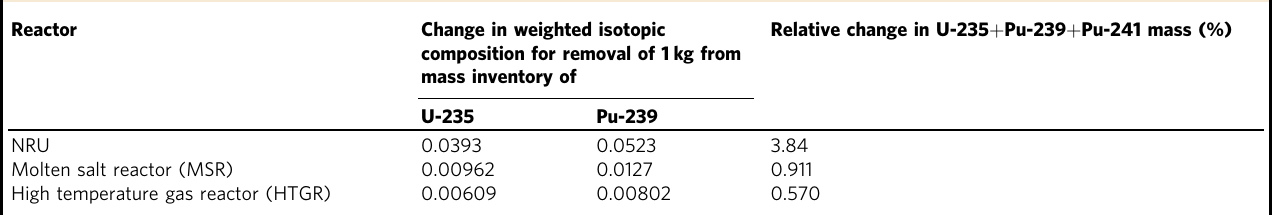
Table 4 Change in weighted isotopic composition from removal of 1 kg of U-235 or Pu-239 Relative change in U-235 + Pu-239 + Pu-241 mass (%) Reactor Change in weighted isotopic composition for removal of 1 kg from mass inventory of